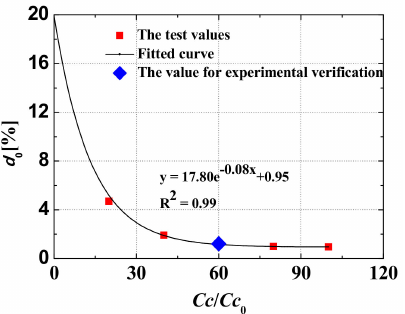
Figure 10. The relationship of the parameter d 0 and cement content Cc .